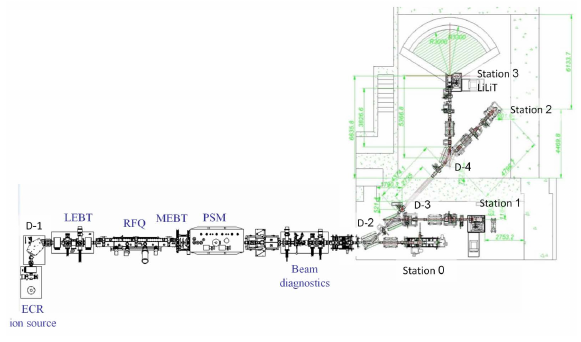
Figure 1. Layout of SARAF Phase I. The recent extension to a new target room (Phase I + ), is shown in green; see text for acronyms. The experiments described in Section 3 were per- formed at Station 1.